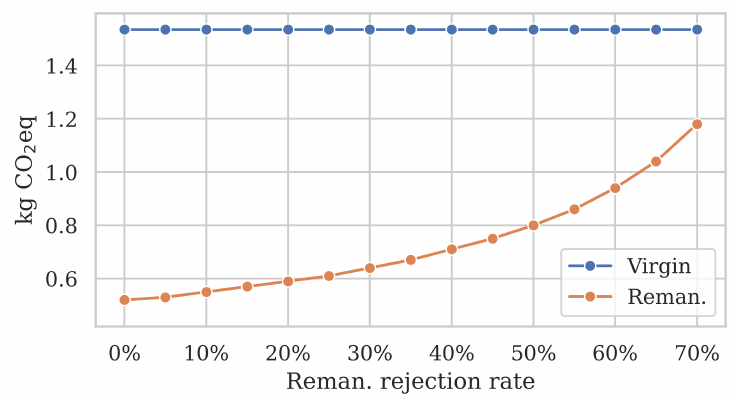
Figure 6. Sensitivity analysis of the rejection rate R. Burden-free remanufacturing emissions E f r increase exponentially as the rejection rate grows. Since 100% of virgin catheters are discarded after use, their emissions E f v are not